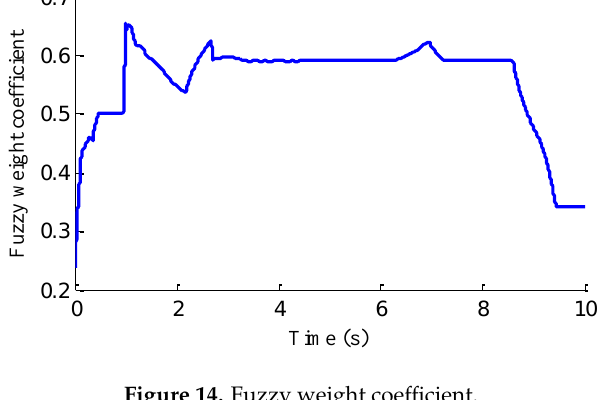
Figure 14. Fuzzy weight coefficient.